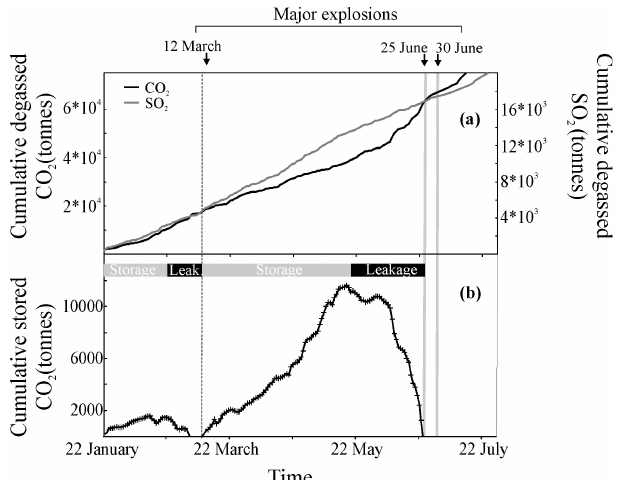
Fig. 4. (a) Cumulative CO 2 (black curve) and SO 2 (grey curve) fluxes (in tonnes), from 22 January to 30 July 2010. Note that the CO 2 scale (left) is 3.5 times greater than the SO 2 scale in order to normalize to the time-averaged CO 2 /SO 2 mass ratio of Stromboli’s emissions. The two cumulative trends are fairly parallel and over- lapping in January–March 2010. After the 12 March 2010 major explosion, the cumulative CO 2 flux first decelerates (during March to May) and then accelerates (in May–June) relative to the SO 2 flux. This suggests an episode of gas retention, followed by passive gas leakage, prior to the major explosions on 25 and 30 June (see text). The cumulative masses of stored CO 2 (e.g., CO 2 segregated deep in the system, possibly as a bubble foam layer) are calculated (in b) as the difference between the amount of CO 2 which would have been degassed in time-averaged conditions (CO 2 /SO 2 of 3.7) and the ac- tual (measured) amount of degassed CO 2 . Cumulative storage of CO 2 occurs at a mean rate of 1.4kgs − 1 from 13 March to 22 April, then 2.5kgs − 1 from 23 April to 20 May, resulting in bulk accu- mulation of ∼ 11000t of carbon dioxide. From 21 May to 10 June (20 days), the stored CO 2 mass remains nearly steady or slightly decreases. Afterwards it suffers a rapid decrease (at a mean rate of 7.7kgs − 1 ) until the two major explosions on 25 and 30 June (pas- sive bubble foam leakage widely prevails over bubble storage). A similar (but smaller) cycle of CO 2 storage-leakage is observed prior to the 12 March weaker